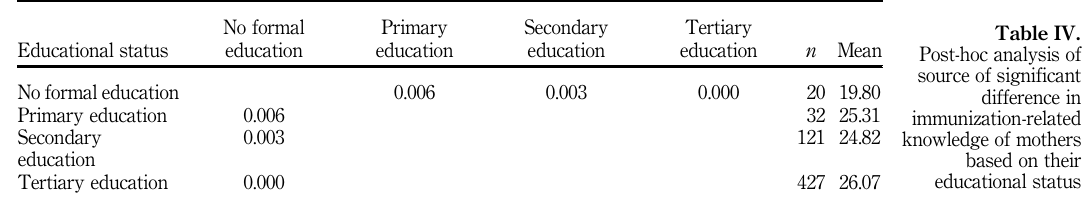
Table IV. Post-hoc analysis of